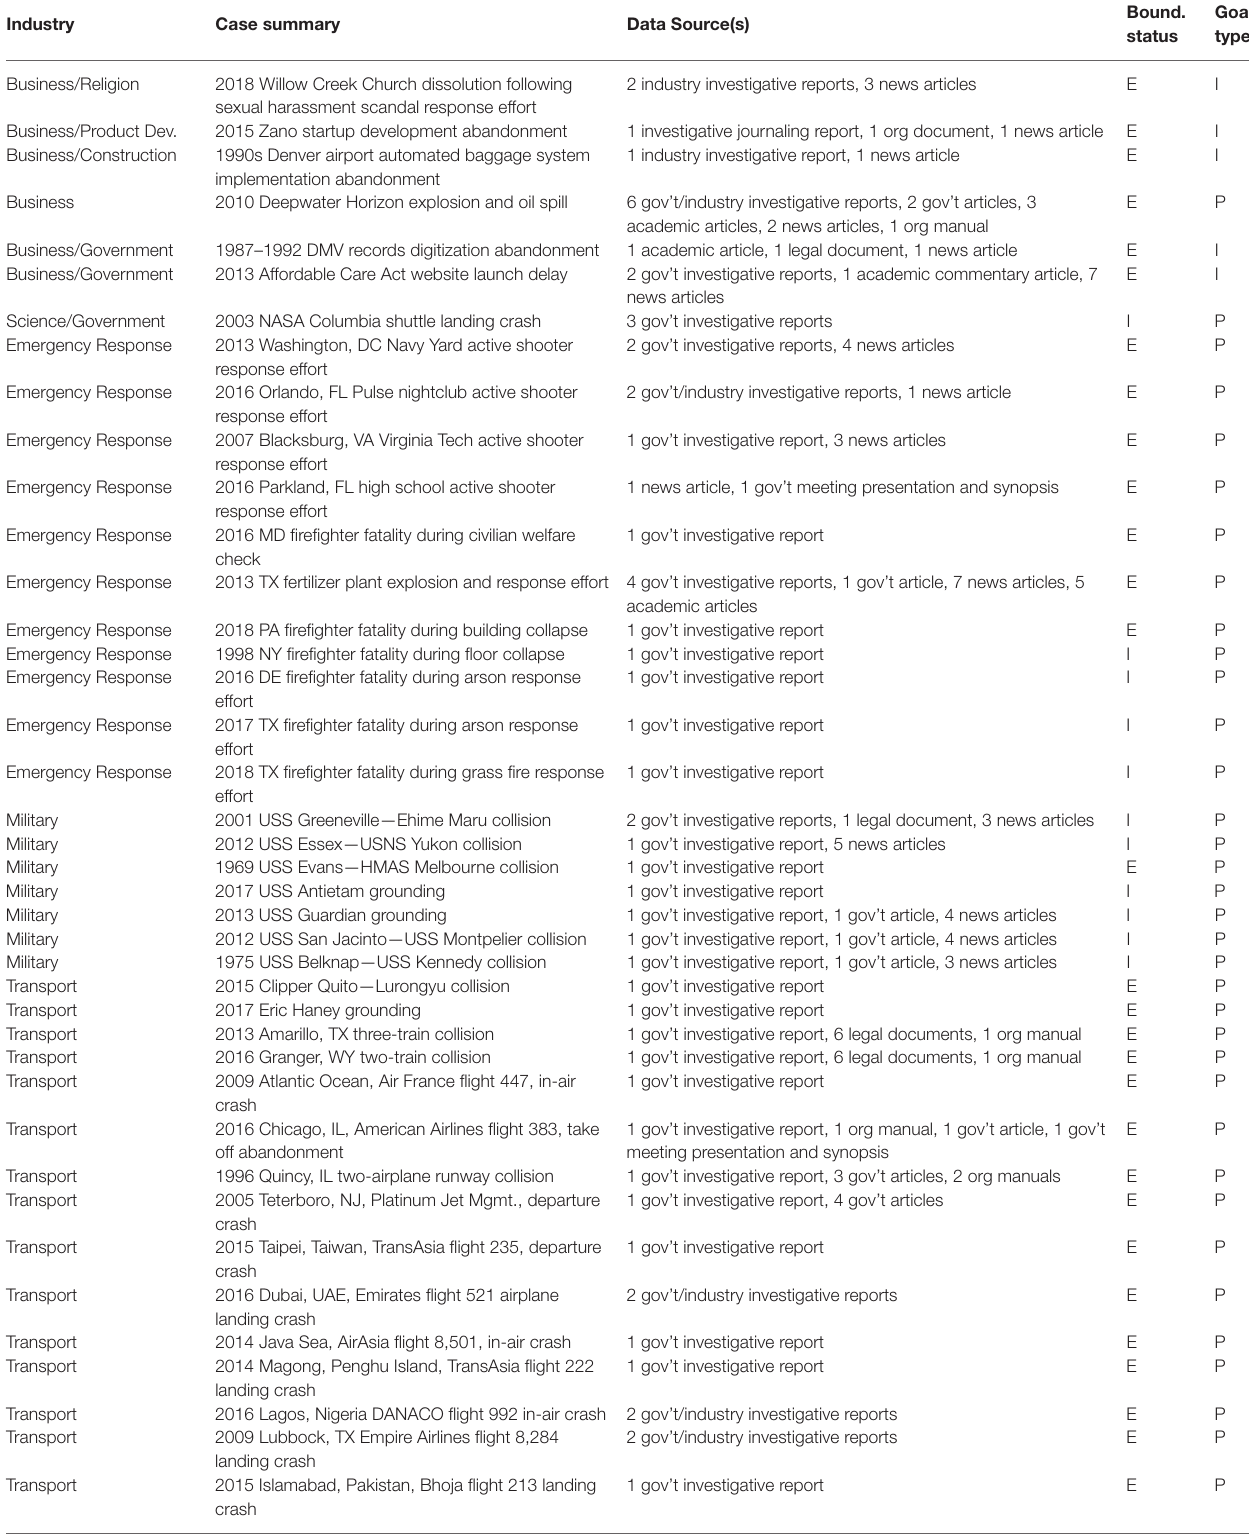
TABLE 2 | Included Cases of Failed MTS